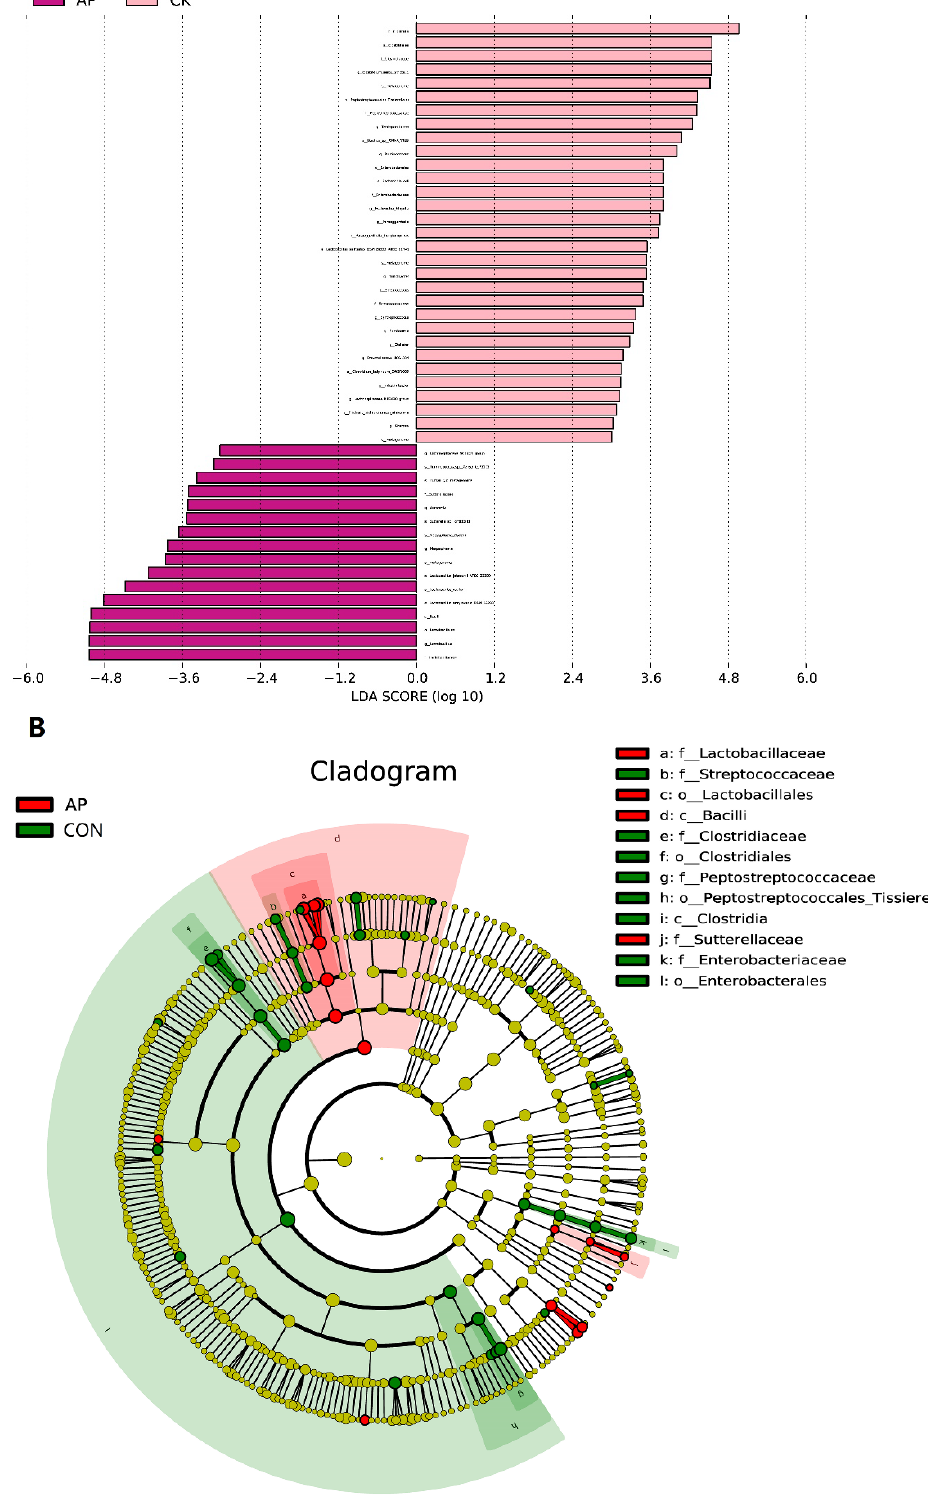
Figure 3. Linear discriminant analysis effect size (LEFse) analysis on fecal microbiota. ( A ) Linear discriminant analysis (LDA). ( B ) LEfSe taxonomy cladogram: different colors suggest enrichment of certain taxa in AP (red) and CON (green). The nonparametric factorial Kruskal–Wallis rank sum test was used for different species at a significance level of 0.05. CON: control group; AP: Apple pomace group.